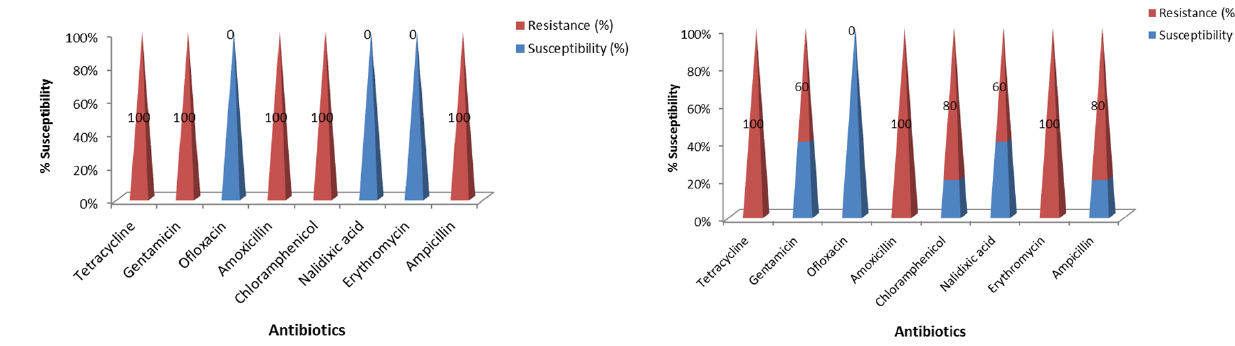
Fig. 5. Antibiogram of Shigella dysenteriae isolated from cow dung used to fertilize fish ponds in New Bussa Nigeria